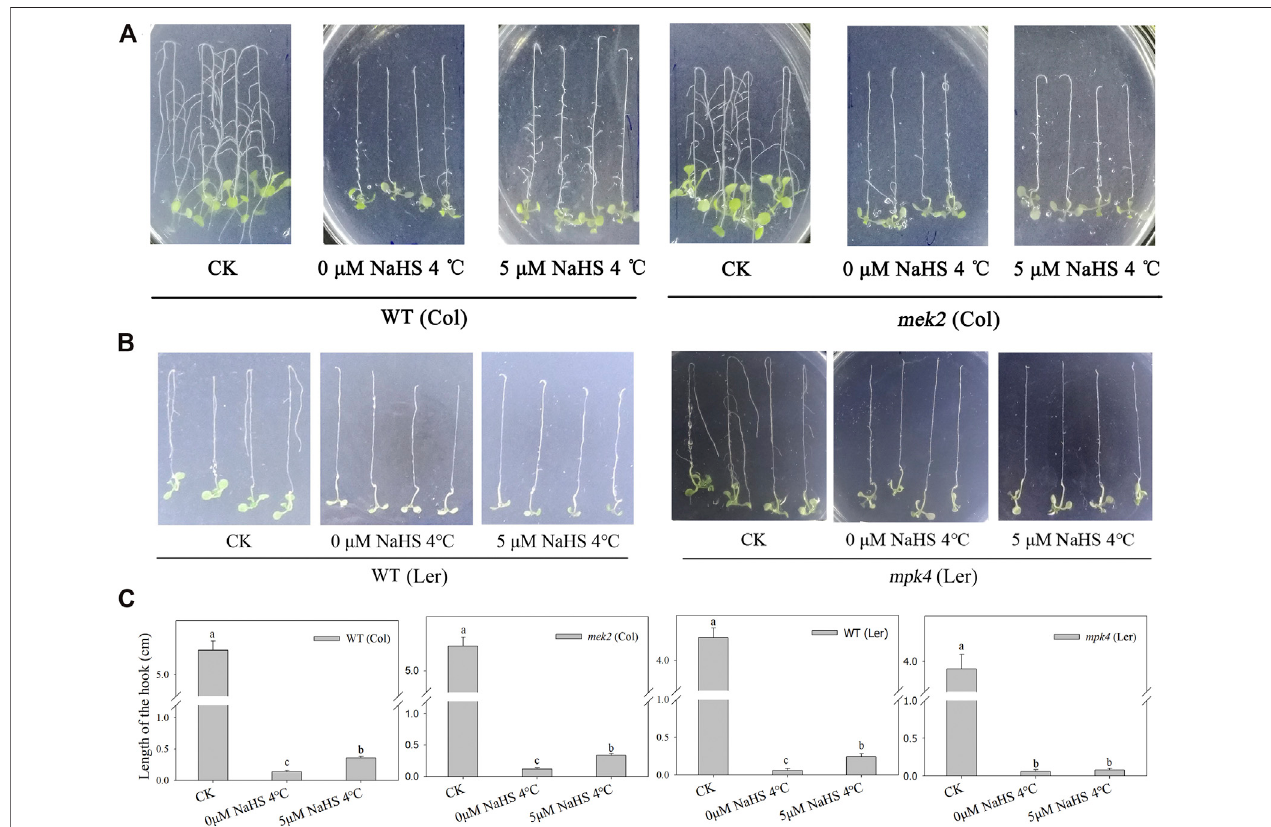
FIGURE 1 | The alleviation effect of H 2 S in WT and mek2 (A) , and mpk4 (B) under cold stress. (C) . the quantitative analysis of hook of root bending in a and b. 1- week-old seedlings that grown on the 1/2 MS plates were fumigated by 5 μ M NaHS for 12 h or not before transferred to 4 ° C inverserly. CK was still grown in 23 ° C inversely. The hook of root tip bending was observed 4 days later. Data are Mean ± SE and three independent experiment were repeated, different letters in c indicated signi fi cant differences among treatments (one way ANOVA p <